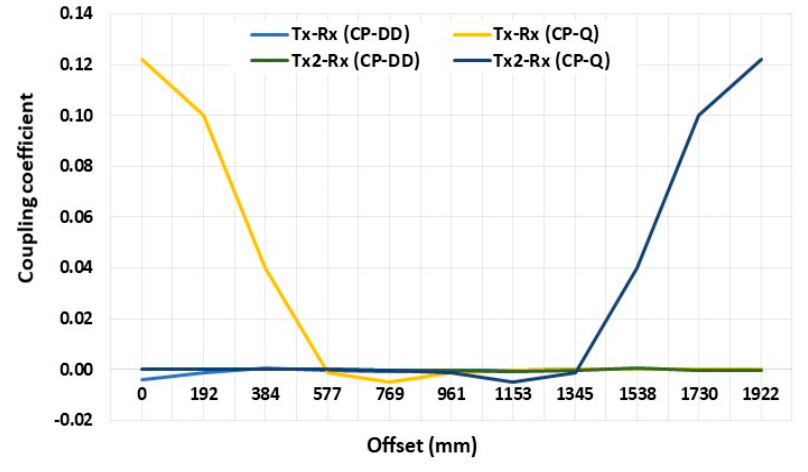
Figure 22. Variation of the coupling coefficient (k) for every step of the Offset in the CP–DDQ configuration.